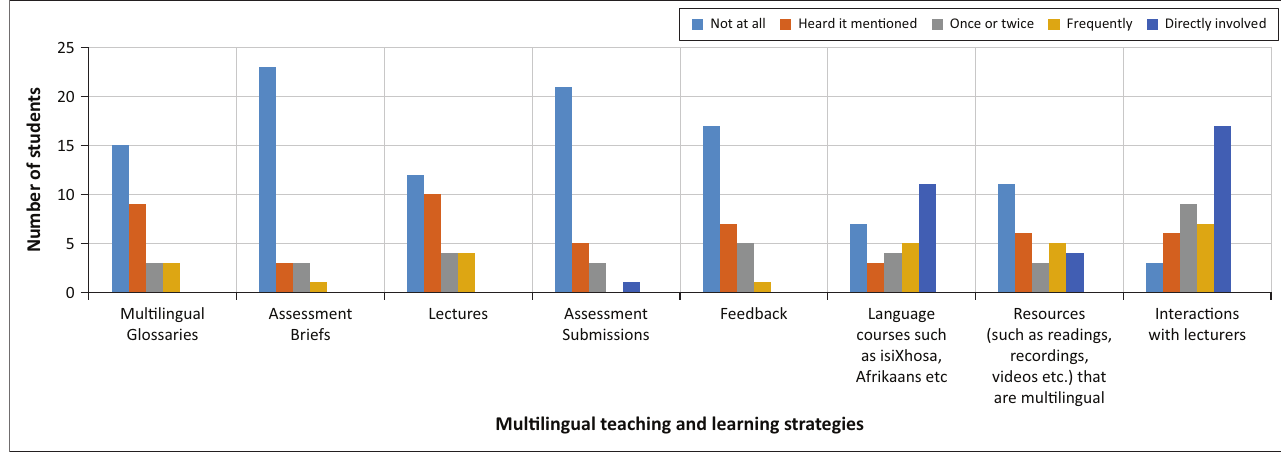
FIGURE 6: Strategies where exposure to multilingualism has